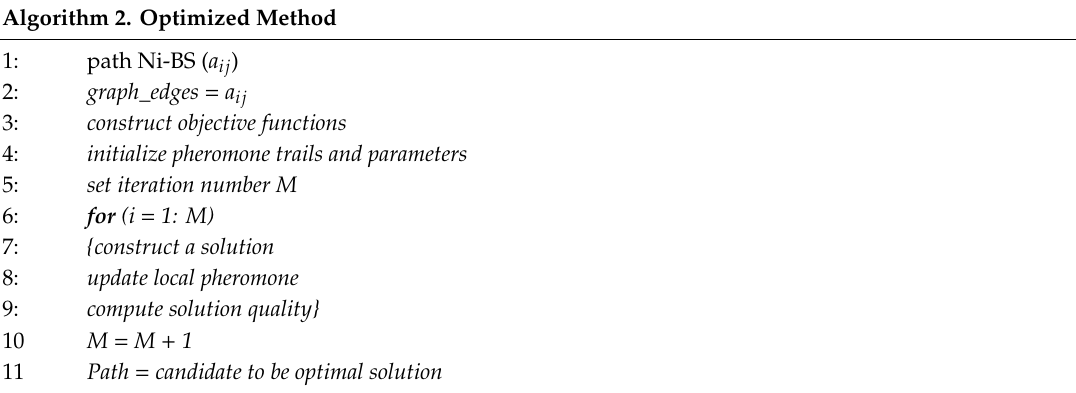
Algorithm 2. Optimized